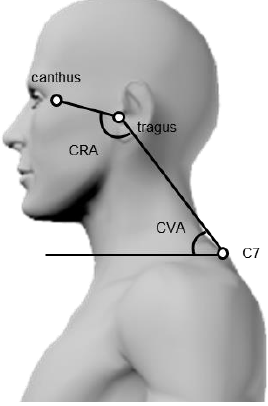
Figure 1. Measurement of cervical sagittal alignment on photographs. Cranial vertical angle (CVA): C7 – tragus – horizontal angle; Cranial rotation angle (CRA): canthus – tragus – C7 angle.